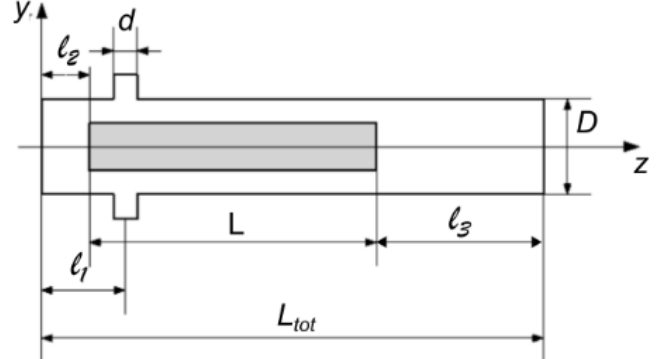
Figure 5. The simplified gripper model for CFD analysis.